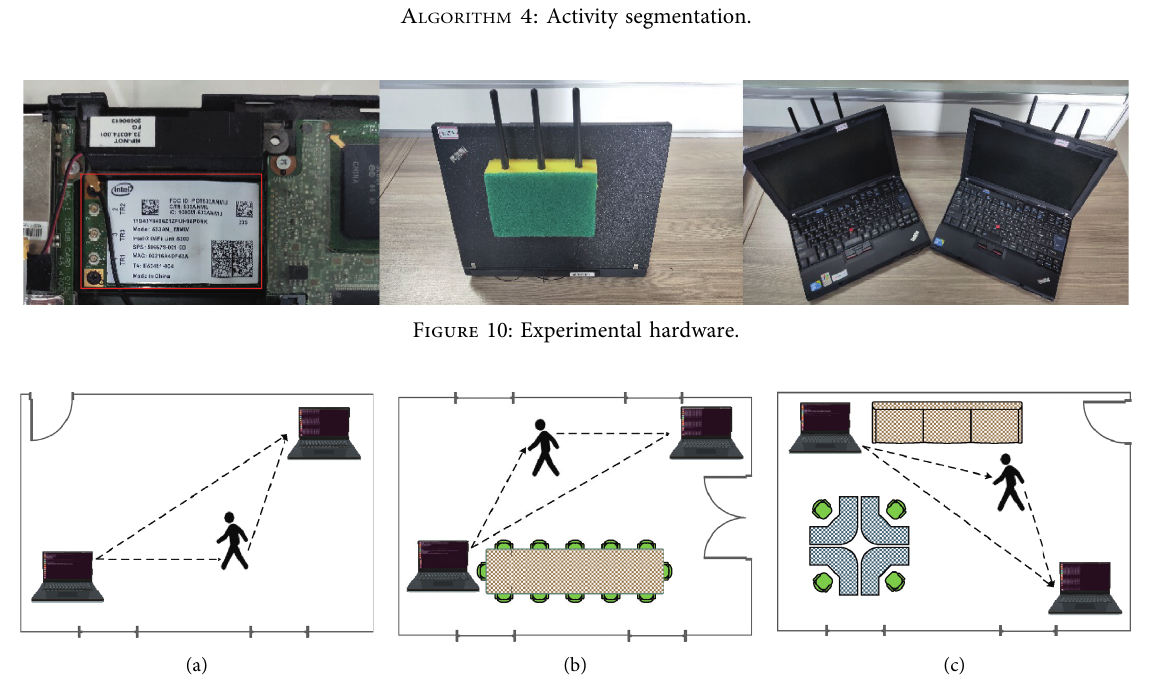
Figure 11: The scenarios of human activity experimental: (a) empty room, (b) meeting room, and (c) research room.